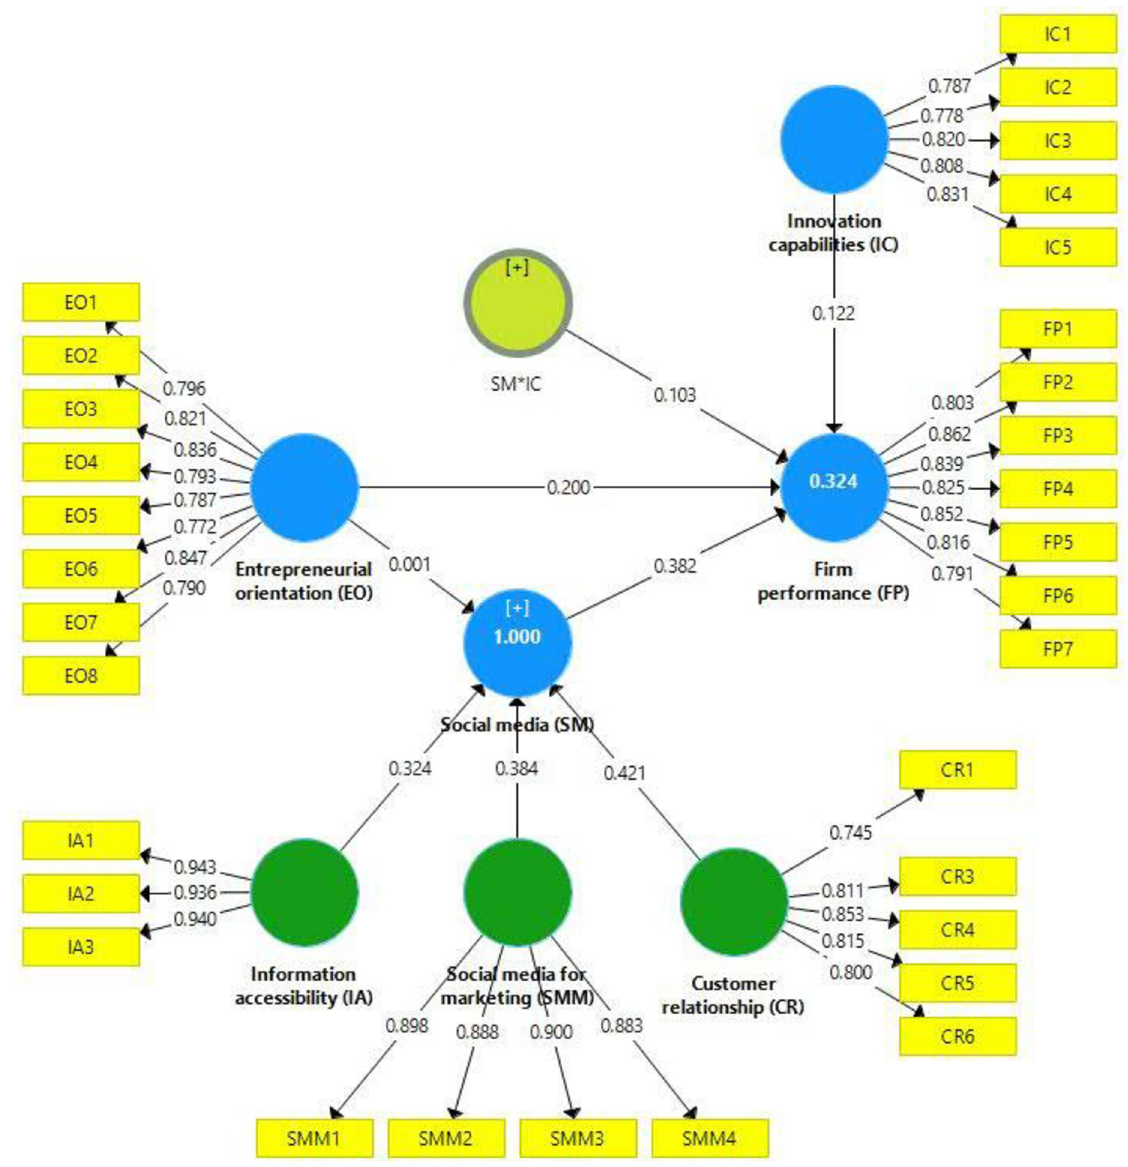
Fig 2. Structural equation